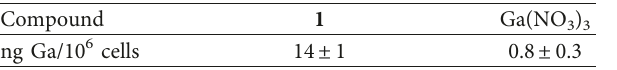
Table 2: Cellular internalization of Ga from 1 and Ga(NO cells determined by ICP-MS.